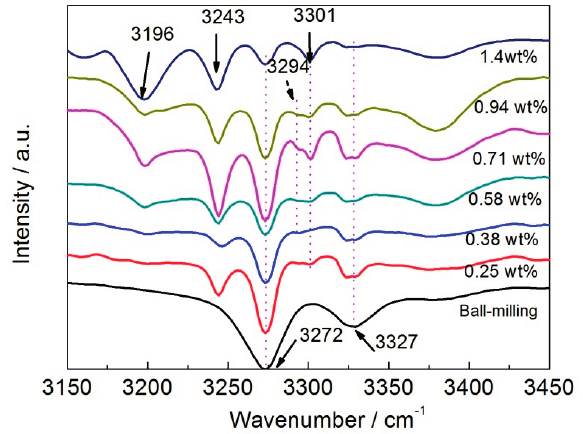
Figure 7. FT-IR spectra of N–H stretching vibrations from T 2 (2Mg(NH 2 ) 2 –3LiH–LiBH 4 ) samples collected at 460 K at different degree of dehydrogenation: 0 wt%, ball-milling stage;